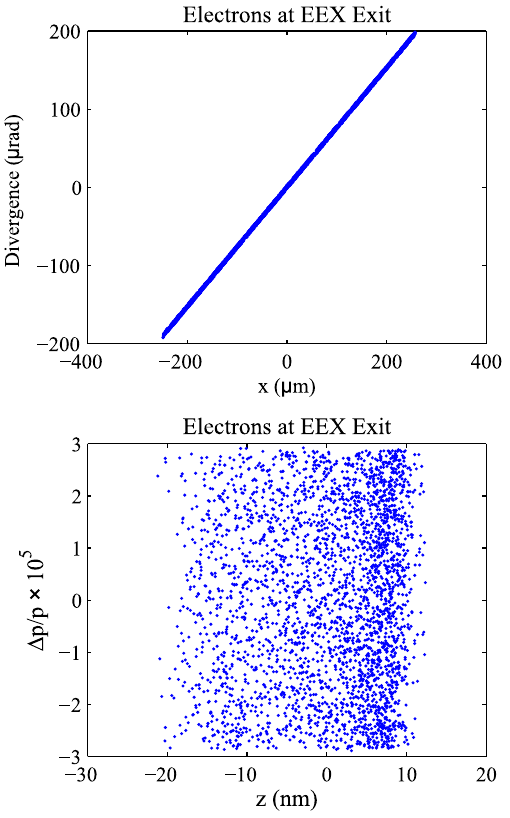
FIG. 4. The phase space of the output electron bunch in the (top) transverse and (bottom) longitudinal dimension when the aberration correcting optics are turned off. A large emittance growth is observed, primarily due to errors that are coupled into the longitudinal dimension of the electron